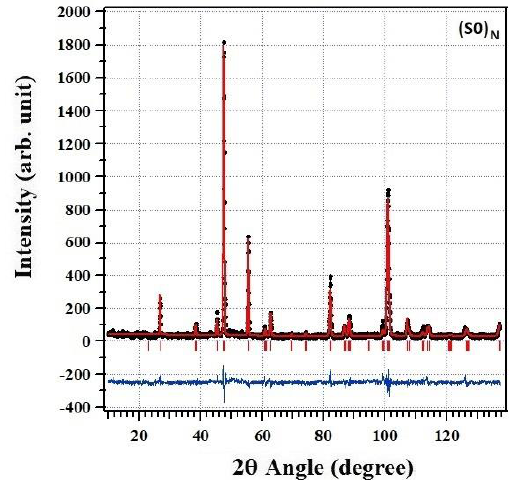
Figure 5. Neutron diffraction patterns of LaMnO 3 (S0), the Rietveld analysis results based on the nuclear phase only without involving magnetic phase, with  2 = 1.9